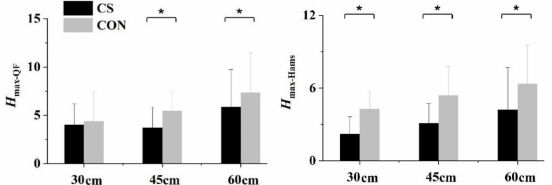
Figure 7. Compression effects on the peak transmissibility ( H max ) of quadriceps femoris (QF) and hamstrings (Hams) during landings. Upper-pointing brackets (*) indicate a significant difference at the certain height ( p < 0.05).